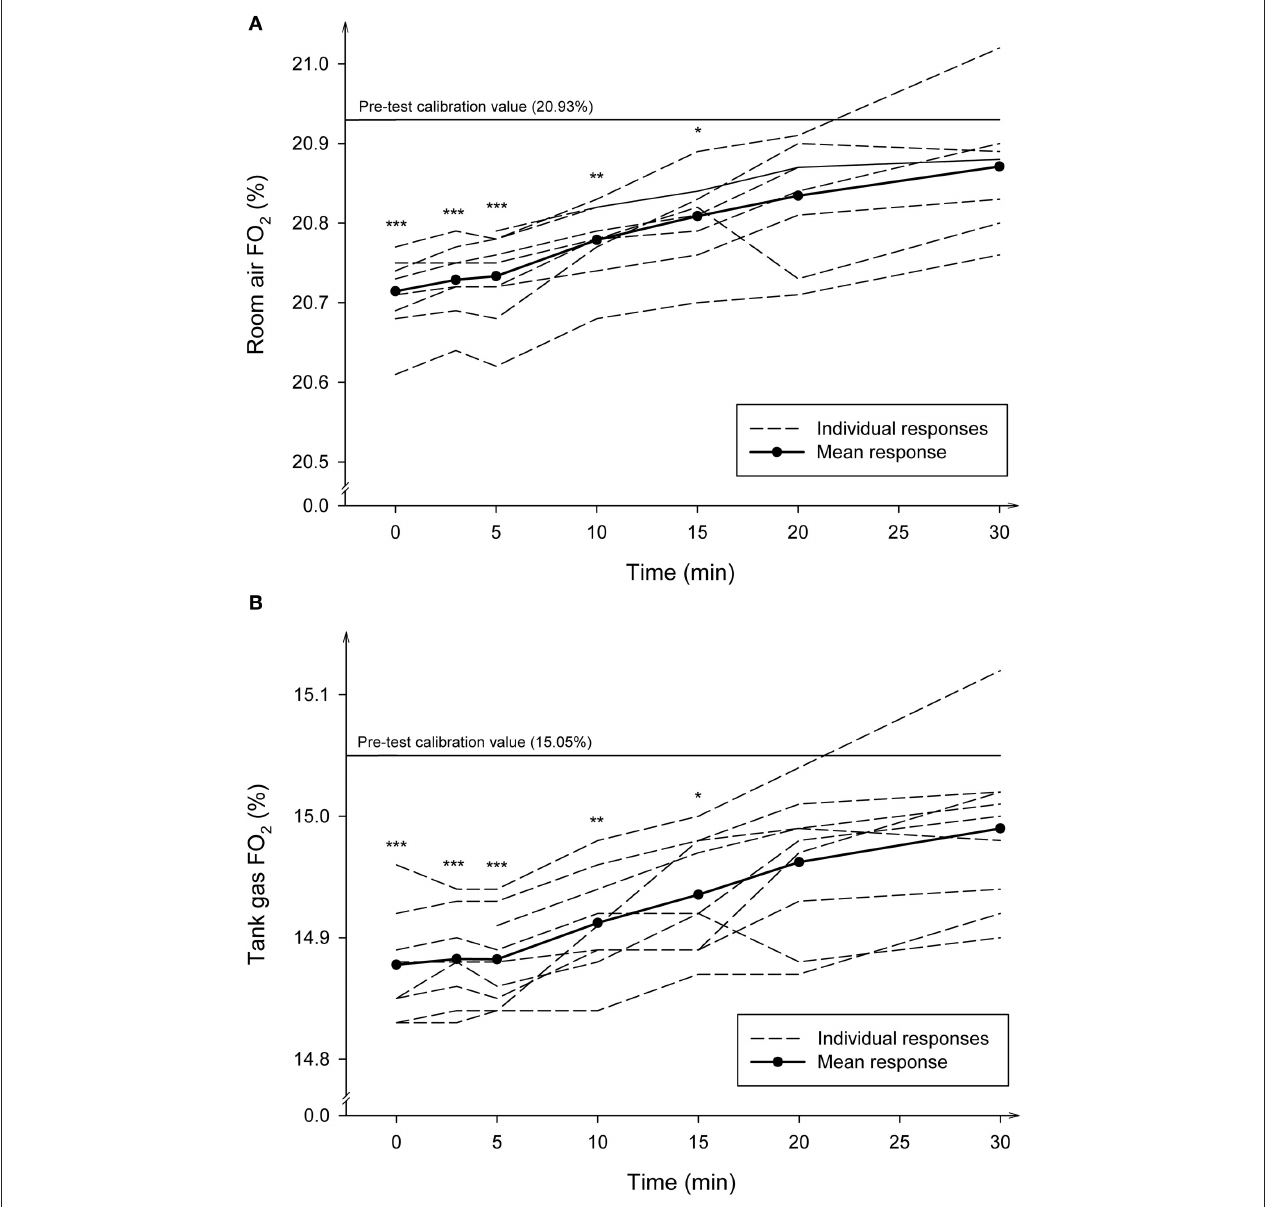
FIGURE 4 | Average and individual time course of the fractional concentrations of oxygen (FO 2 ) during recovery after maximal exercise. The post-test verification values read by the gas analyzers using the room air (A) and the tank gas (B) were measured at 20s, 3, 5, 10, 15, 20, and 30min of recovery. The number of observations made at each time-point was 9. *** Significantly different from pre-test ( P < 0.001 ); ** Significantly different from pre-test ( P < 0.01 ); * Significantly different form pre-test ( P < 0.05